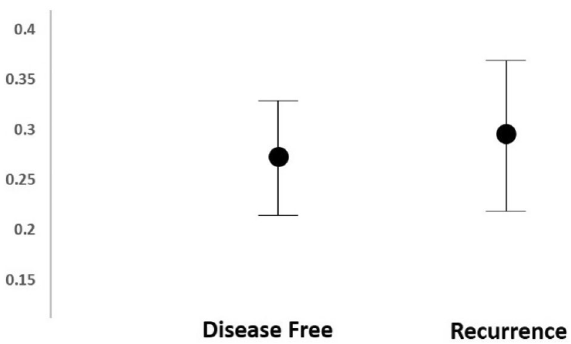
Figure 5. Mean ± SD of NF-kB expression. Patients with or without